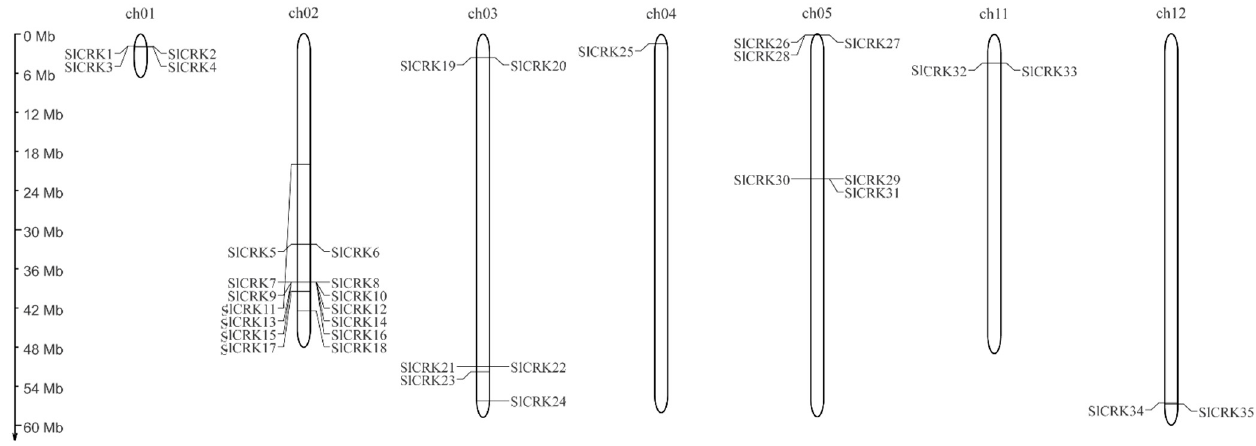
Figure 2. Genetic map of SlCRK genes in 7 chromosomes out of the 12 chromosomes of Solanum lycopersicum .